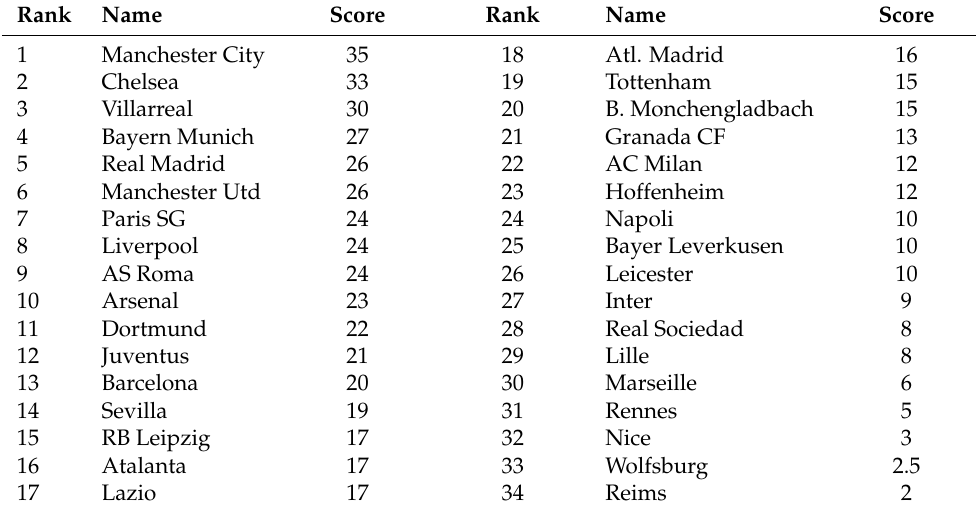
Table 7. UEFA club coefficient rankings.